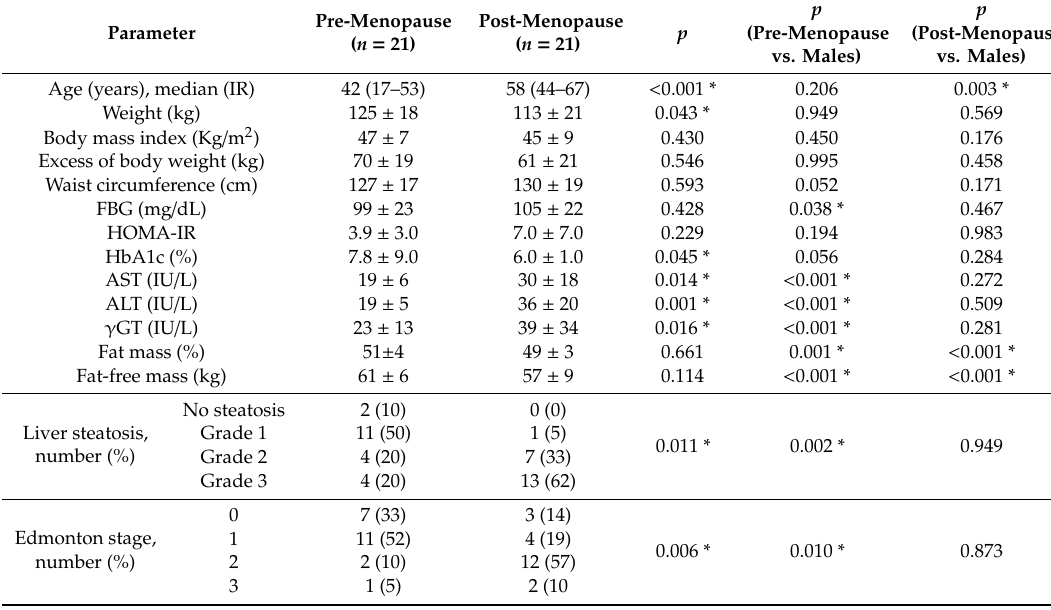
Table 2. Comparison of the anthropometric, bioimpedentiometric, biochemical, and ultrasonographic parameters between pre- and post-menopausal aged females at baseline (Student’s t -test, Kruskal–Wallis test, and χ 2 test). Comparisons with male subjects are also reported (for the means and standard deviations (SDs) of male subjects, refer to Table